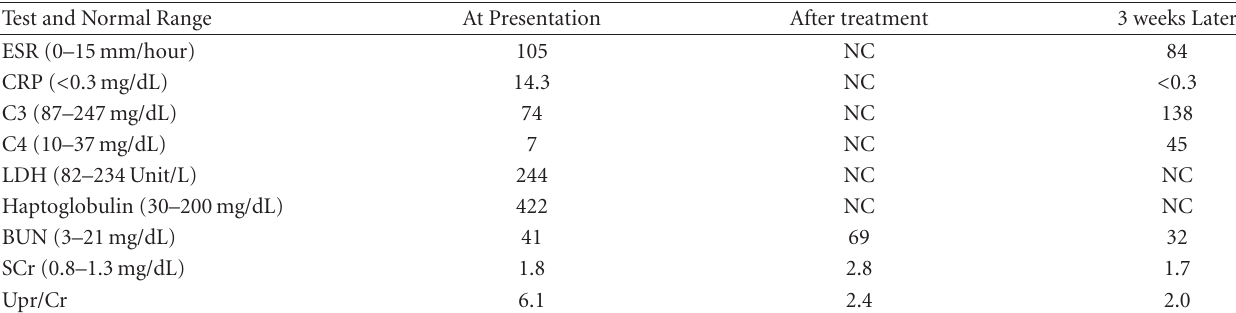
Table 2: Some of the serum sickness-specific laboratory findings before and after the treatment.